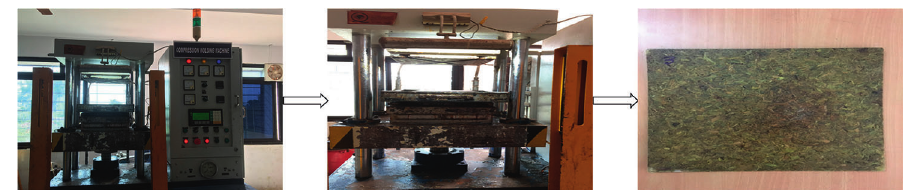
Figure 2: Fabrication process of water hyacinth plant fibre composite.